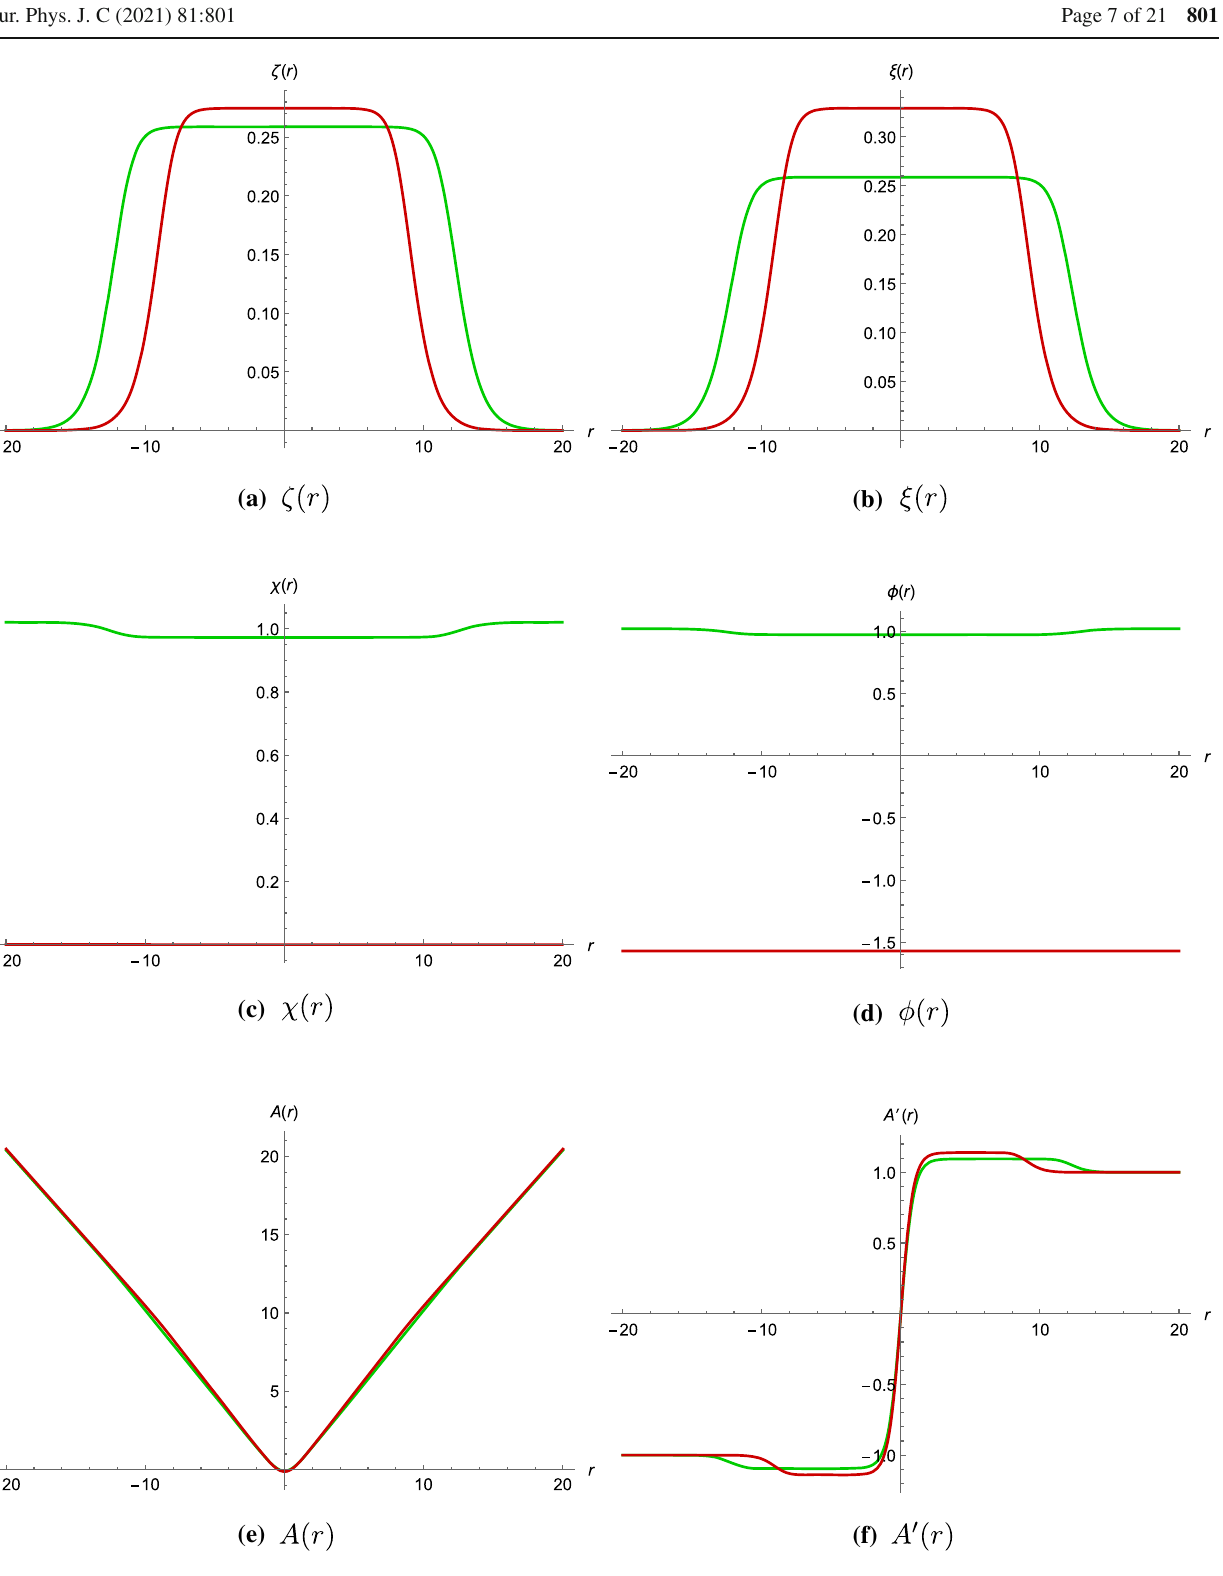
Fig. 2 Profiles of scalar fields (ζ,ξ,χ,φ) and the warped factor A as functions of the radial coordinate r for SO ( 8 )/ SO ( 8 ) Janus solutions that flow to G 2 and U ( 3 ) critical points are shown by green and red lines,